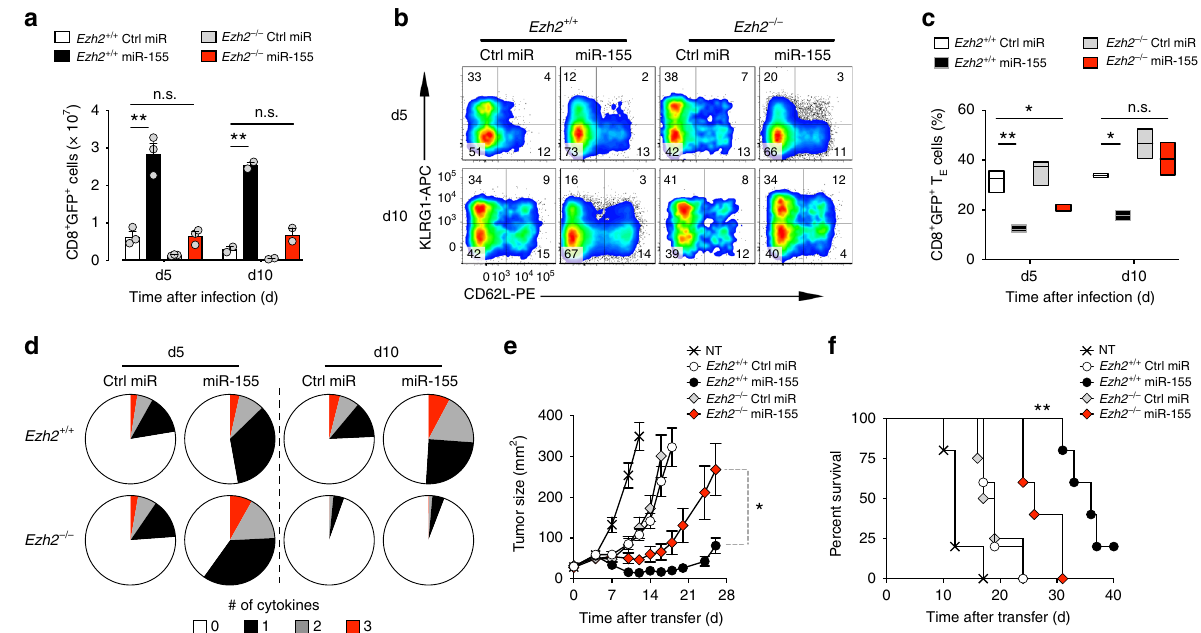
Fig. 2 Ezh2 is required for the enhanced CD8 + T cell antitumor immunity conferred by miR-155. a Number of live CD8 + GFP + T cells in the spleen assessed at day 5 and 10 following adoptive transfer of 3 × 10 5 pmel-1 Ezh2 + / + or Ezh2 − / − CD8 + T cells transduced with miR-155 or Ctrl-miR into B16 tumor-bearing mice in conjunction with gp100-VV. Bars represent the mean ± s.e.m. of three or two individual mice. b Flow cytometry of splenic CD8 + GFP + T cells 5 and 10 days after transfer as in a . Numbers indicate the percentage of cells after gating on live CD8 + GFP + T cells. c Percentage of splenic pmel-1 CD8 + GFP + T E cells at indicated time points after transfer. Data are presented as box plots extending to minimum and maximum values. Bands inside the boxes represent median values of three individual mice. d Combinatorial cytokine response of splenic CD8 + GFP + T cells 5 and 10 days after transfer as in a , as determined by the Boolean combination of gates identifying IFN- γ + , IL-2 + , and TNF + cells. Data are presented as the mean of three individual mice. e − f Tumor size (mean ± s.e.m.) ( e ) and survival curve ( f ) of B16 tumor-bearing mice after adoptive transfer of 4 × 10 6 cells generated as in a in conjunction with gp100-VV ( n = 5 mice/group). NT no treatment. Data are representative of two independent experiments. * P < 0.05; ** P < 0.01 (unpaired two-tailed Student ’ s t